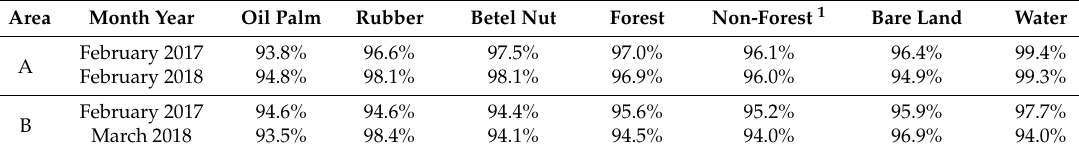
Table 8. Median producer’s accuracy per class across the four